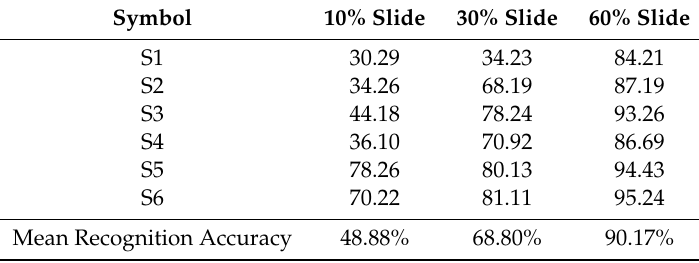
Table 9. IM-SB dataset results for di ff erent sliding windows ratios.